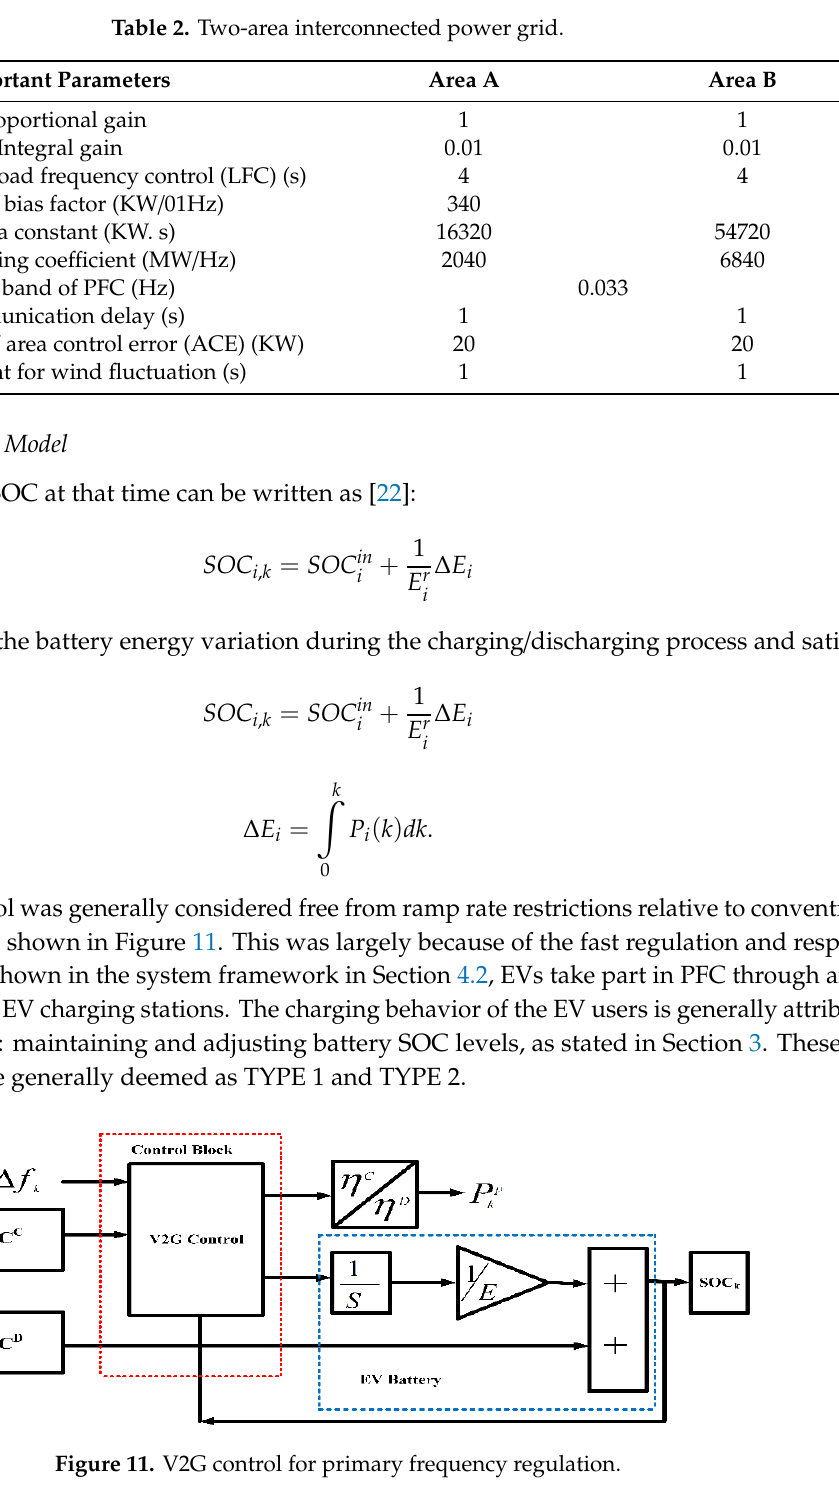
Table 3. Simulation parameters of V2G.